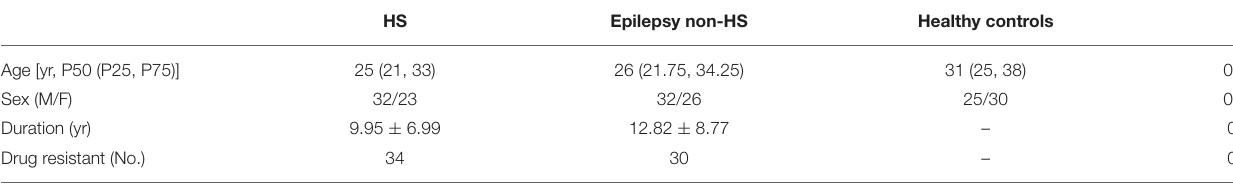
TABLE 1 | Demographic and clinical features.